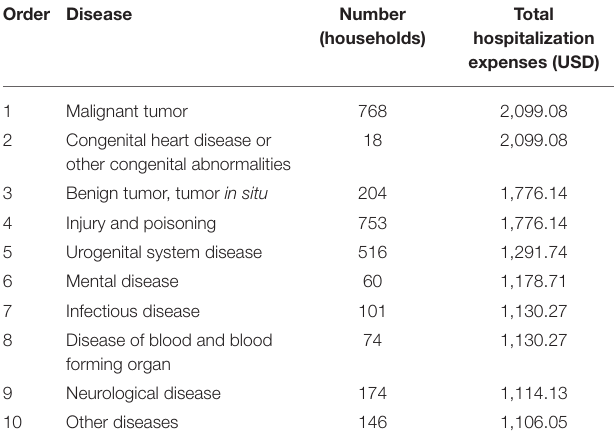
TABLE 6 | Top 10 diseases with the highest total hospitalization expenses of households with CHE. Order